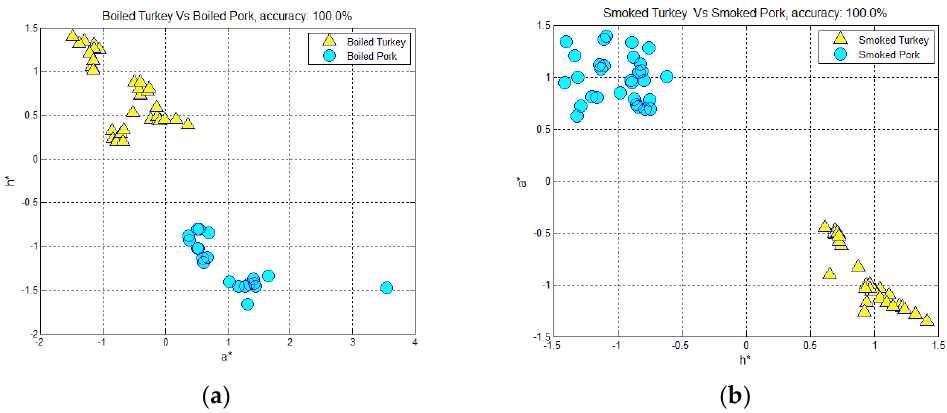
Figure 3. Scatter diagram displaying the discrimination, employing the color parameters and textural features, between: ( a ) boiled turkey and pork hams; ( b ) smoked turkey and pork hams.